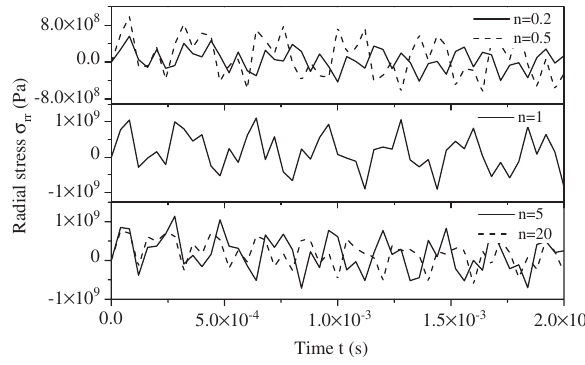
Figure 12 Response histories of radial stress in the FGM hollow cylinder with different n , where r = 0.375 m.